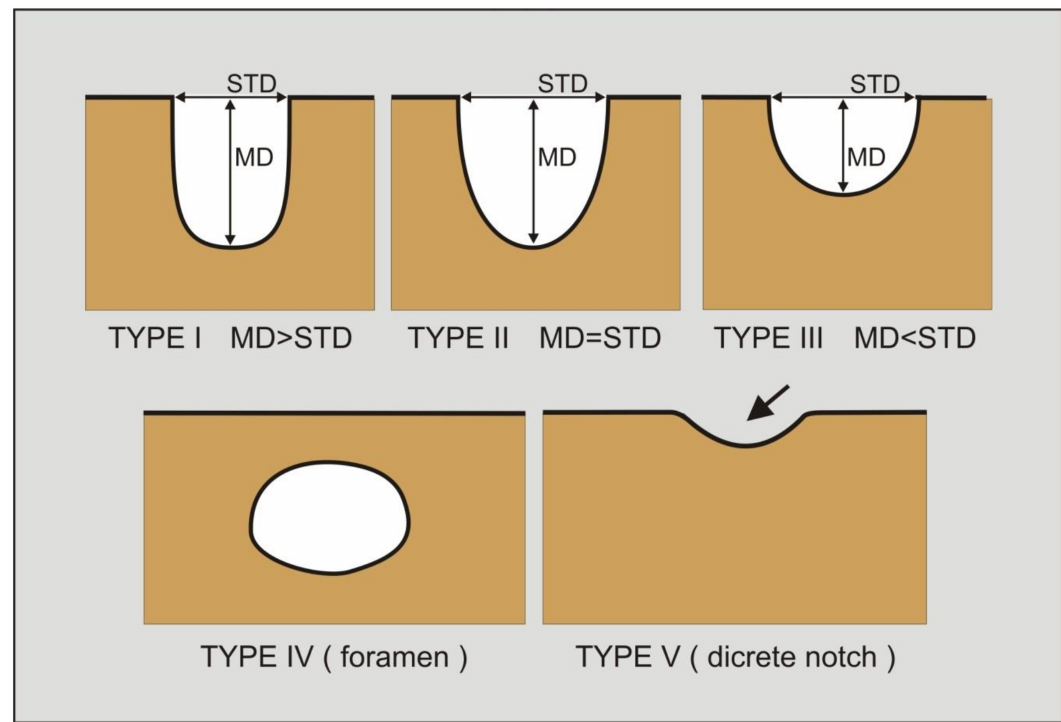
Figure 5. Classification of the suprascapular notch variations. MD: maximal depth of the suprascapular notch; STD: superior transverse diameter of the suprascapular notch. Type I: MD is longer than STD; Type II: MD and STD are equal; Type III: STD is longer than MD; Type IV: a suprascapular foramen as a bony foramen; Type V: a discrete notch (arrow).